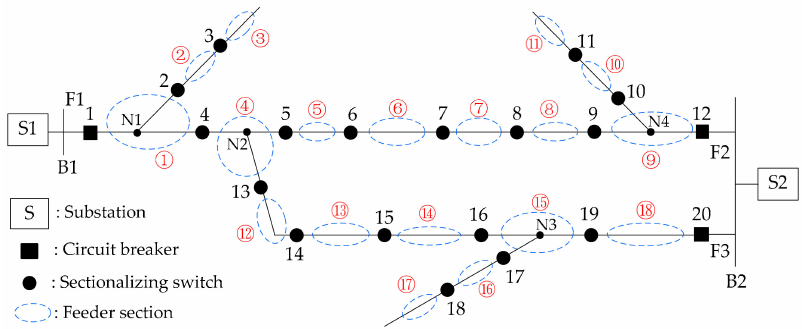
Figure 1. Single line diagram of a simple distribution system with all the switches